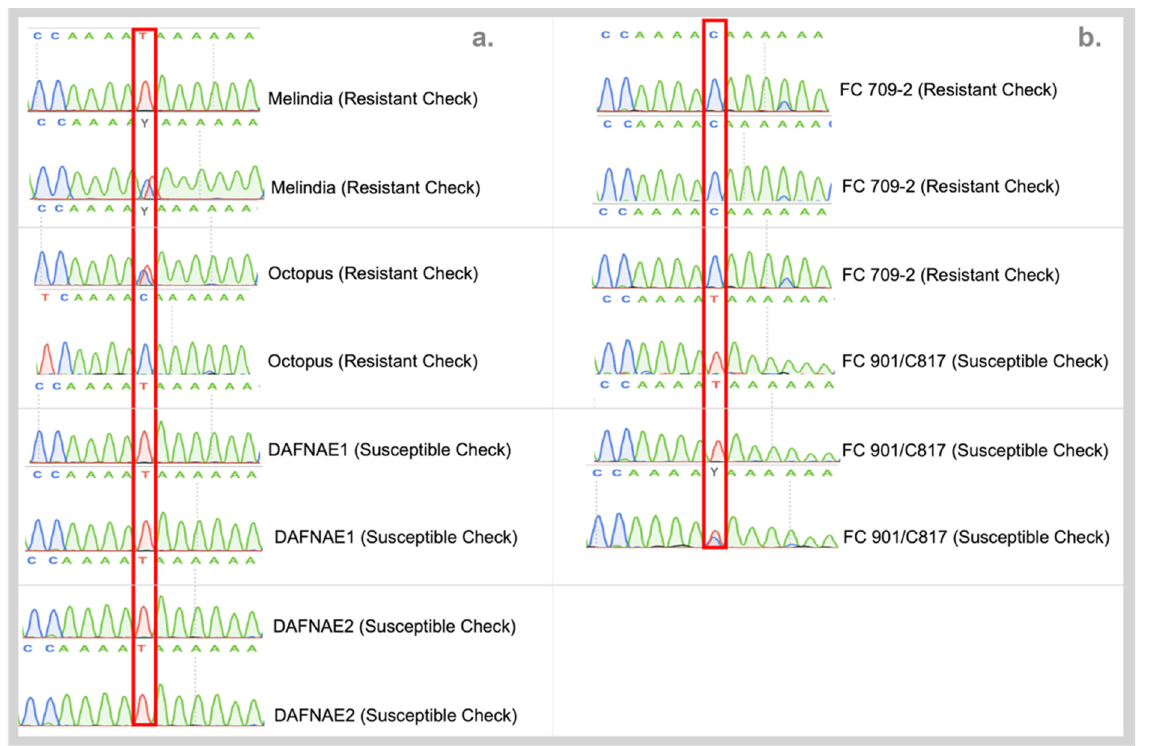
Figure 5. ( a ) Chromatograms from Sanger sequencing of RsBv1 on commercial checks target show predominance of the C allele in resistant plants. ( b ) Validation of RsBv1 on USDA plant material confirming the distinctive allelic status at 9,000,093 bp on Chromosome 6 of sugar beet.